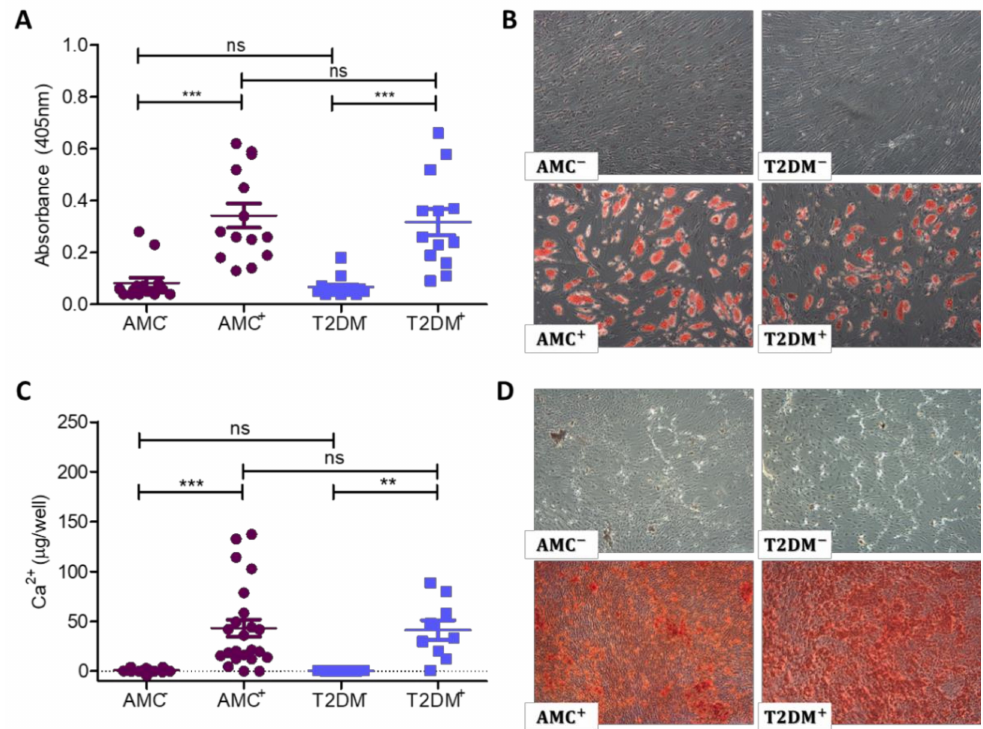
Figure 3. Adipogenic and osteogenic di ff erentiation of MSC cultures. Undi ff erentiated cultures are identified as AMC − or T2DM − , while di ff erentiated cultures are identified as AMC + or T2DM + . ( A ) MSC cultures were induced to form adipocytes, while undi ff erentiated cultures served as a control. Quantification of Oil Red O stain retention indicates a near absence of absorbed stain in undi ff erentiated cultures; then a statistically significantly enhanced retention in di ff erentiated cultures. The presence of T2DM in the donor did not influence the culture’s capacity to undergo adipogenic di ff erentiation ( n = 13 AMC and n = 14 T2DM donor samples). ( B ) Representative images of each donor cohort demonstrating Oil Red O positive cells in di ff erentiated cultures at the same frequency in cultures isolated from individuals with T2DM as in AMC cultures. Images obtained by 4 × objective as described in methods. ( C ) Quantification of extracted calcium from osteogenically di ff erentiated MSC cultures indicated their bone-forming potential. Calcium was present at negligible levels in undi ff erentiated AMC and T2DM control cultures but was significantly enhanced in di ff erentiated cultures. There was no statistically significant impact of T2DM on the capacity of these cells to osteogenically di ff erentiate ( n = 23 for AMC and n = 9 for T2DM cohorts). ( D ) Staining of osteogenically di ff erentiated cultures with Alizarin Red revealed the presence of calcium in the culture’s extracellular matrix. Undi ff erentiated controls were negative for Alizarin Red staining, while di ff erentiated cultures retained stain. The distribution and intensity of the stain was comparable between donor cohorts. Images obtained by 4 × objective as described in methods. All data are displayed as mean ± SEM. * = p ≤ 0.05; ** = p ≤ 0.01, ns = not significant, i.e., p >